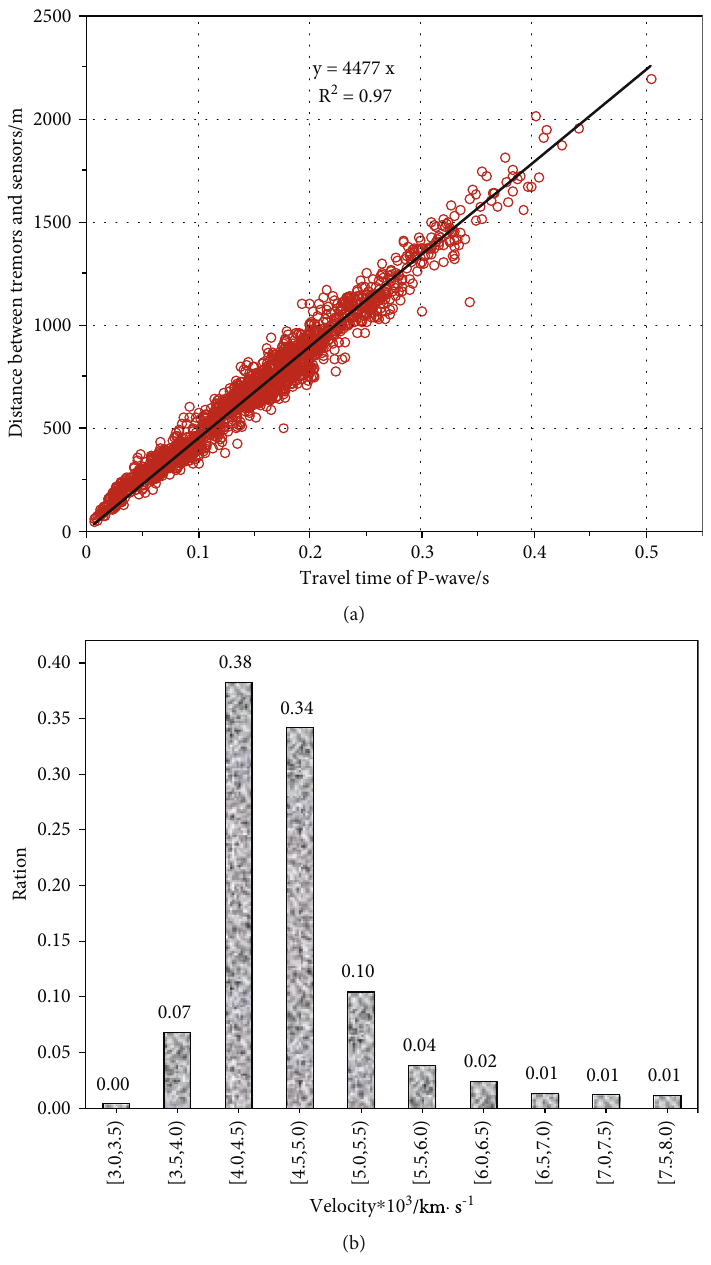
Figure 5: Seismic velocity statistics of the seismic rays in panel